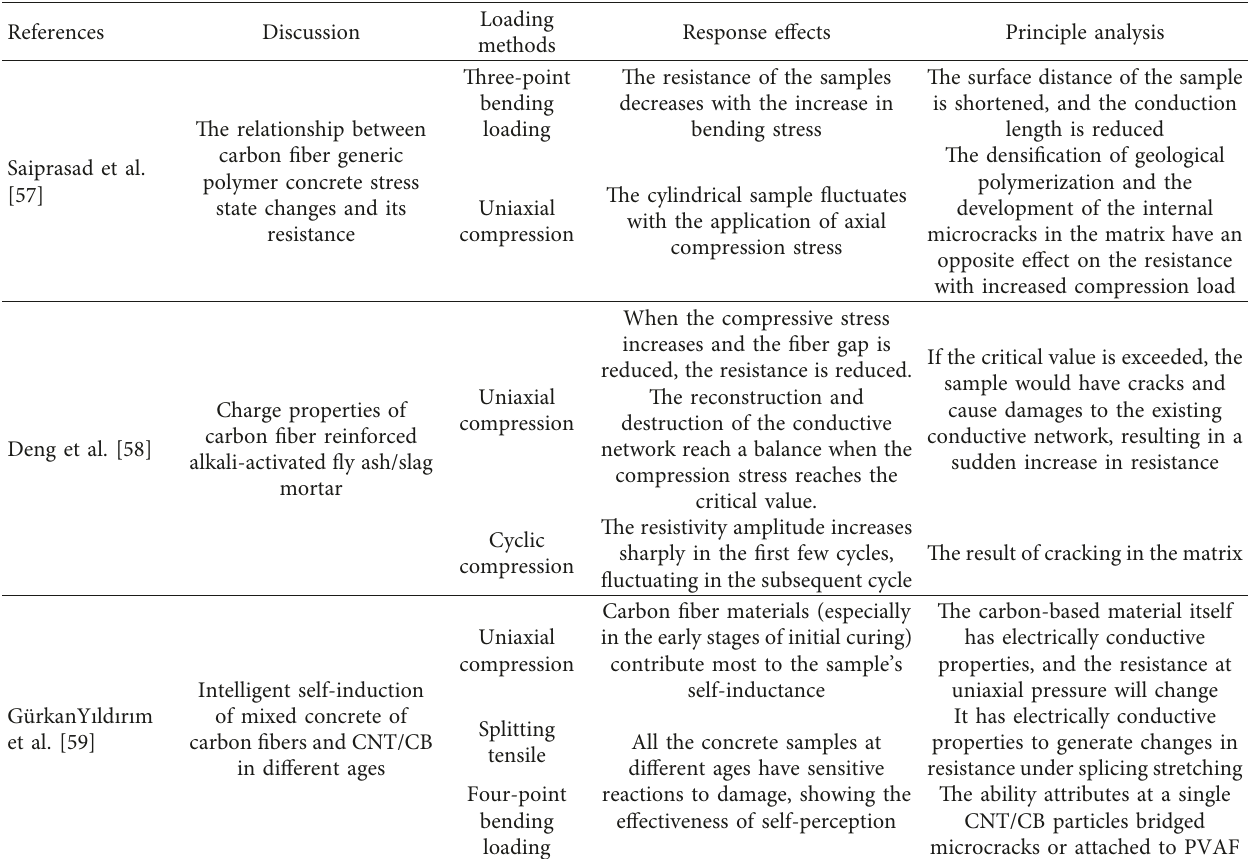
Figure 7: (a) Percolation theory [53]. (b) Electricity flows through concrete in three states: (1) postfiber pullout, (2) fiber bridged cracks, and (3) uncracked [54]. Table 2: Intelligent response fields and effects of different loading methods of